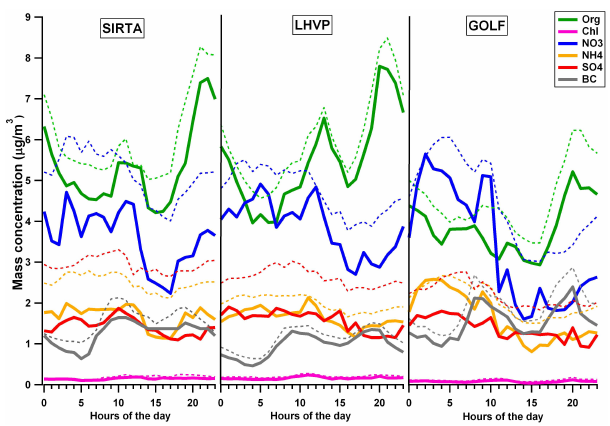
Fig. 2. Diurnal variation of organics, inorganics and black carbon in the Paris region (solid line = median values, dashed line = mean